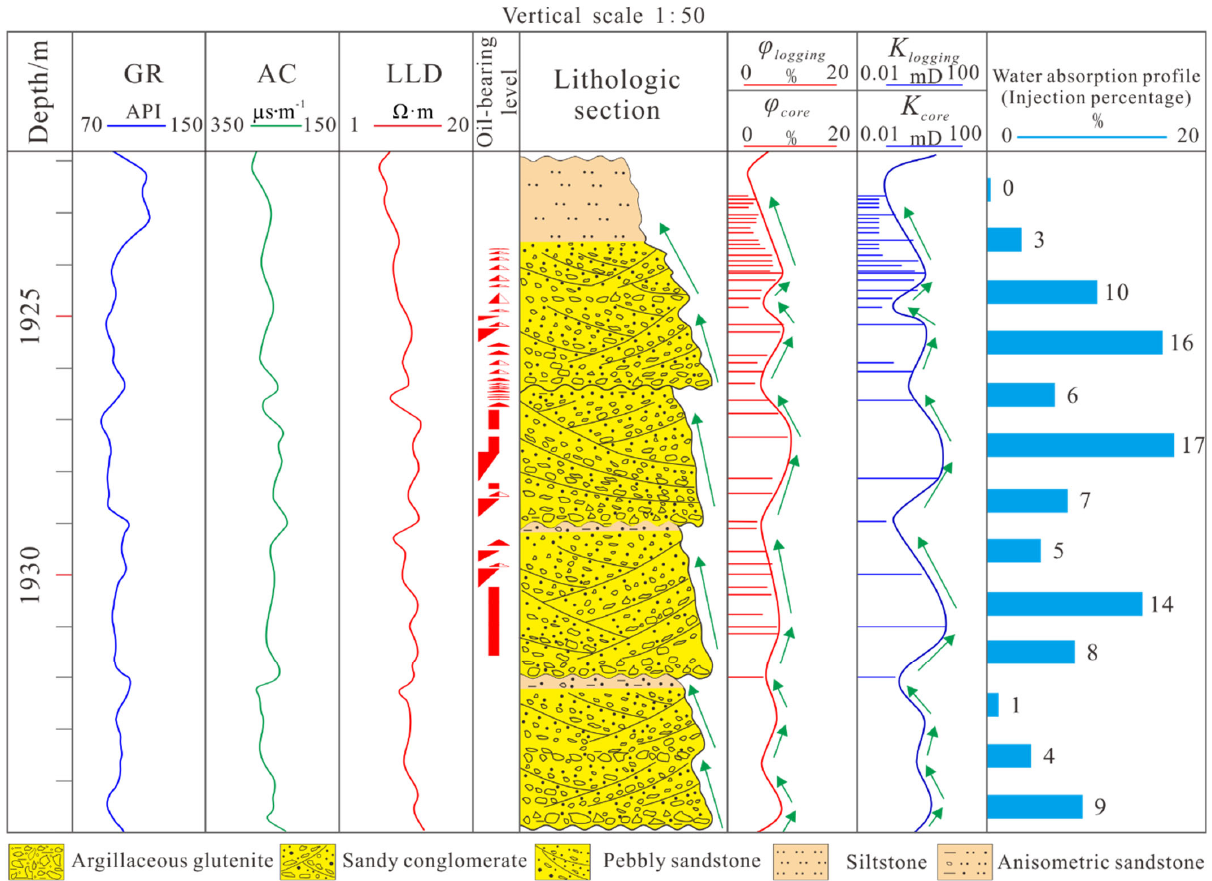
Figure 11. Relationship between permeability compound rhythmicity and water absorption.